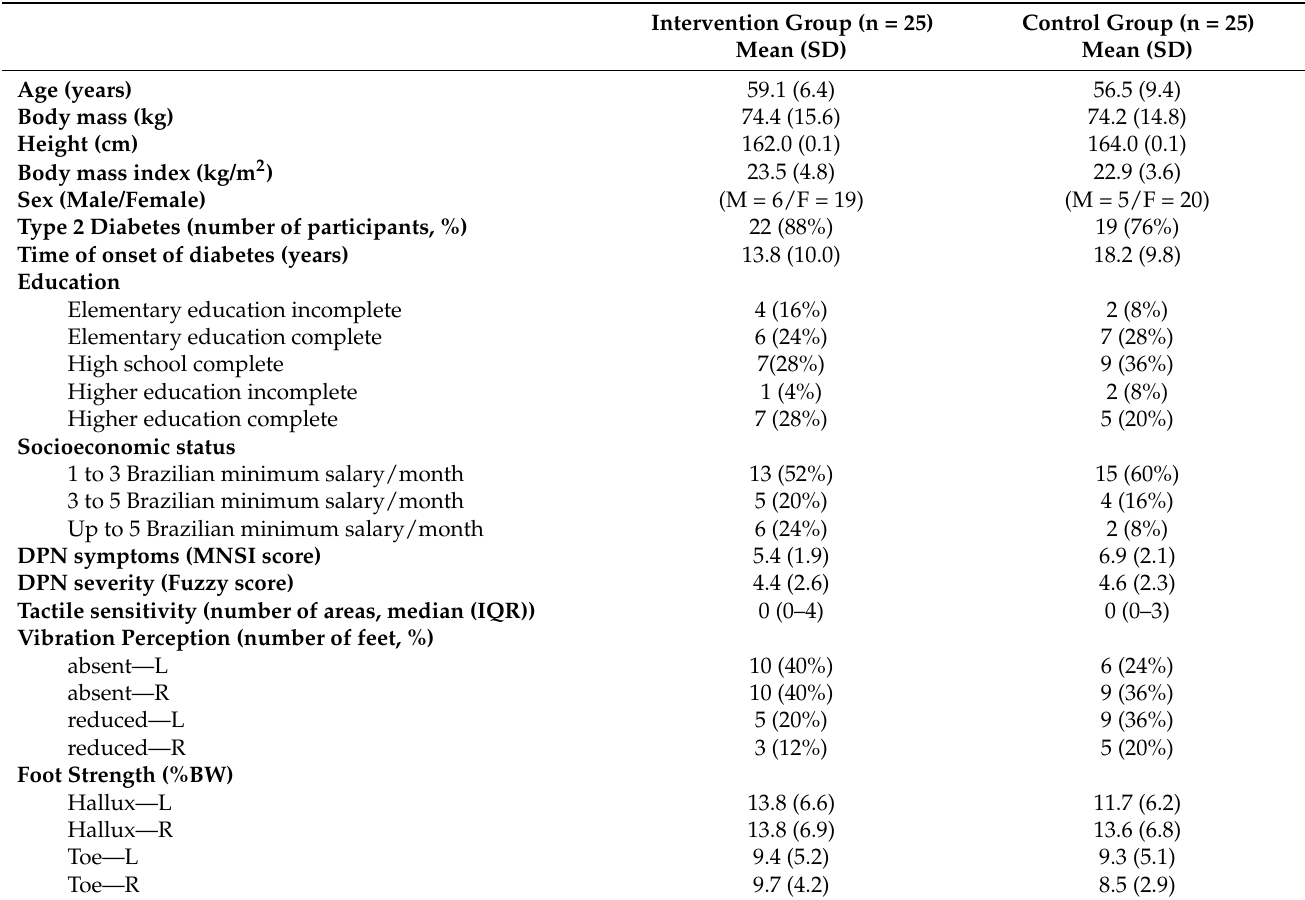
Table 1. DPN-related outcomes and anthropometric and demographic characteristics at baseline for the control and intervention